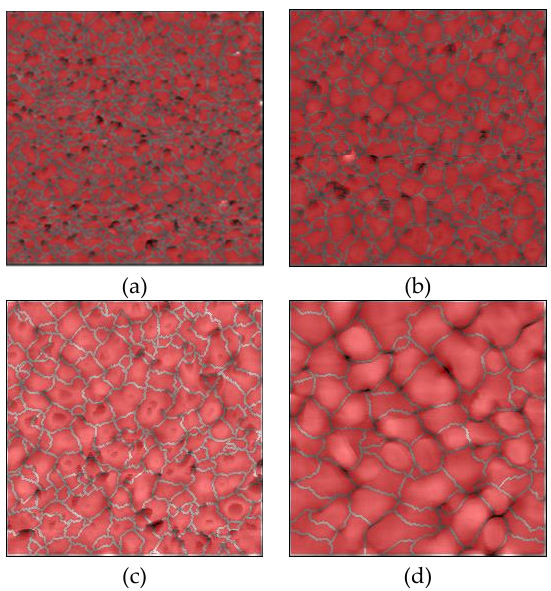
Figure 11. AFM images of Au thin films deposited on Si wafers with cavities with grains segmented using the watershed algorithm: ( a )–( d ) films with thicknesses of 15, 50, 100, 300 nm, respectively.